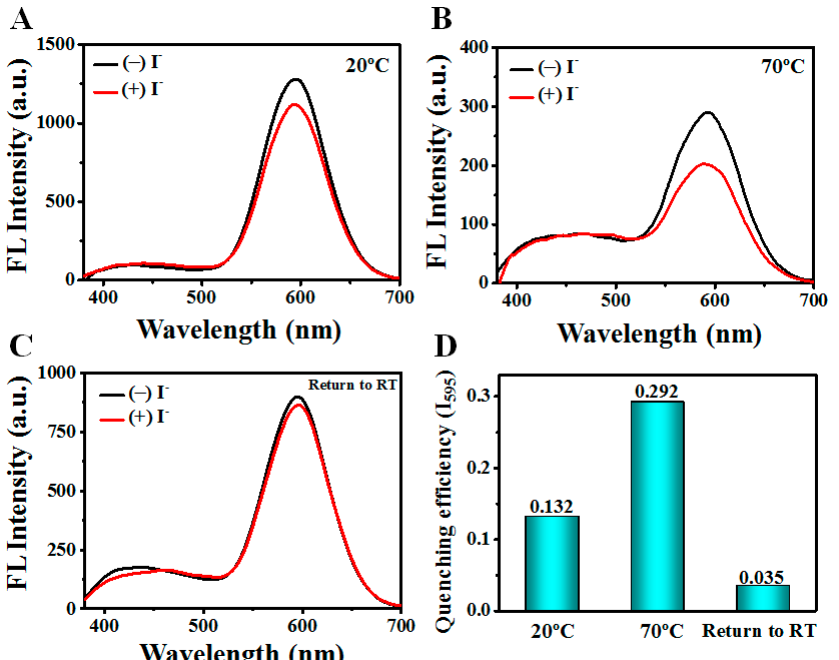
Figure 6. I − quenching behavior investigation. Fluorescence emission spectra of DE-Au NCs in the absence (black line) and presence (red line) of I − under 20 °C ( A ), 70 °C ( B ), and return to room temperature ( C ), respectively. ( D ) Relative fluorescence decreases in red emission under various conditions with the addition of I − .